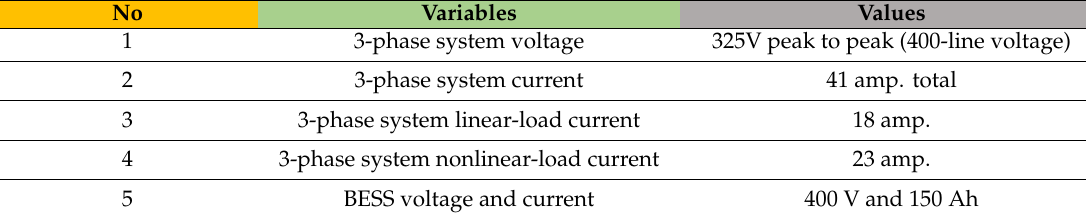
Figure 12. ALARP diagram of frequency level. Table 1. System